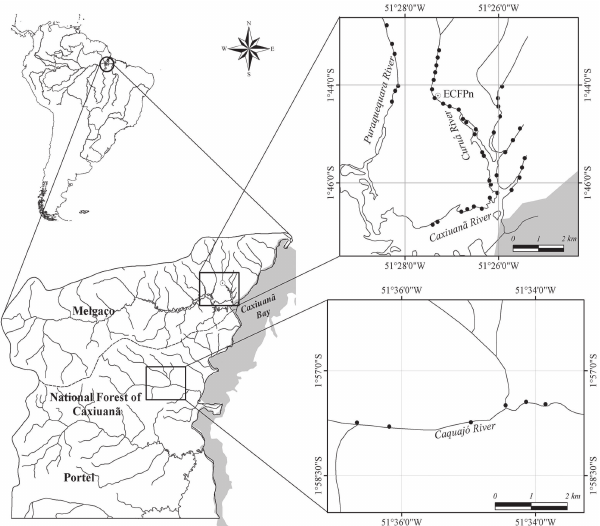
Fig. 1. Sampling area in the National Forest of Caxiuanã, Pará State, showing the rivers where the fish were collected; Curuá River - Ferreira Penna Research Station (ECFPn), Caxiuanã River; Puraquequara River and Caquajó River. A single point on the map may represent more than one colleting